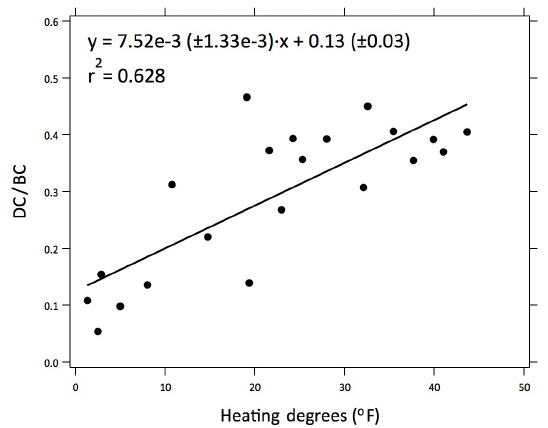
Figure 8. The relationship between DC / BC and HDD, both pre- sented as monthly averaged values based on Rutland data. DC / BC is proposed as a woodsmoke PM emission indicator. The values in- side the parentheses represent the corresponding one standard devi-